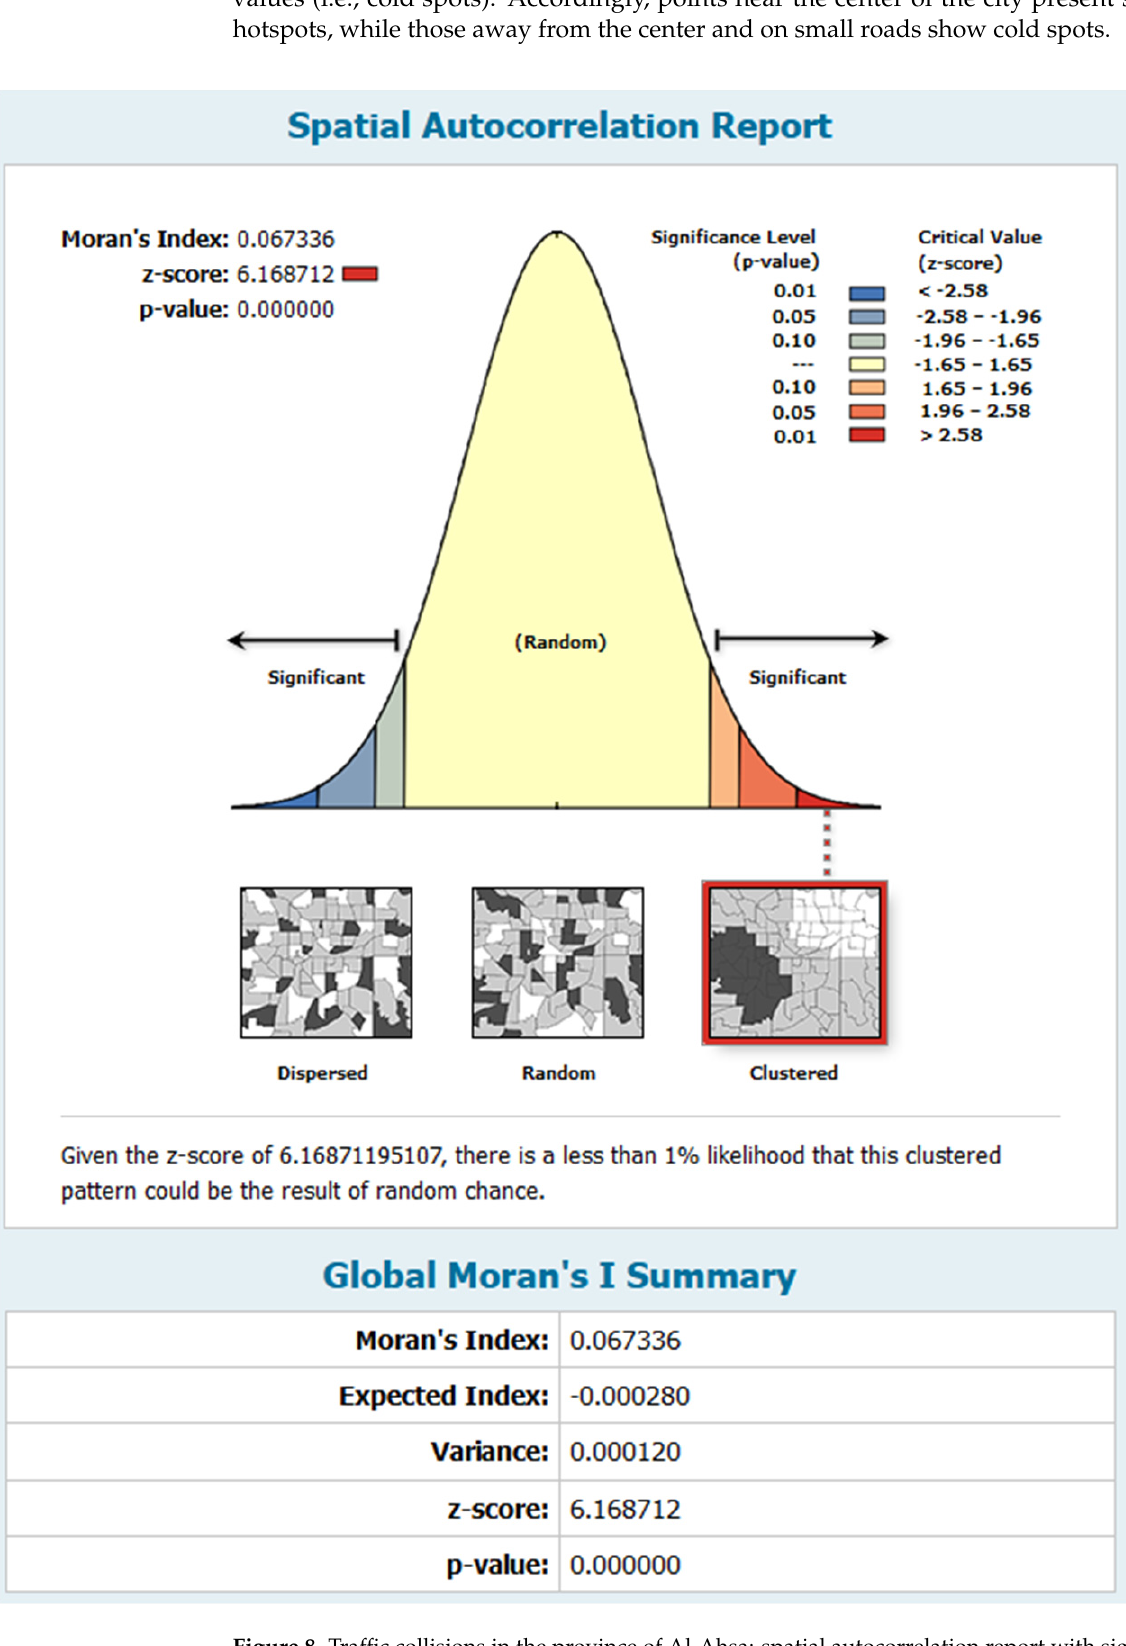
Figure 8. Traffic collisions in the province of Al-Ahsa: spatial autocorrelation report with significance graph of Moran’s I, z-score, and p -value.